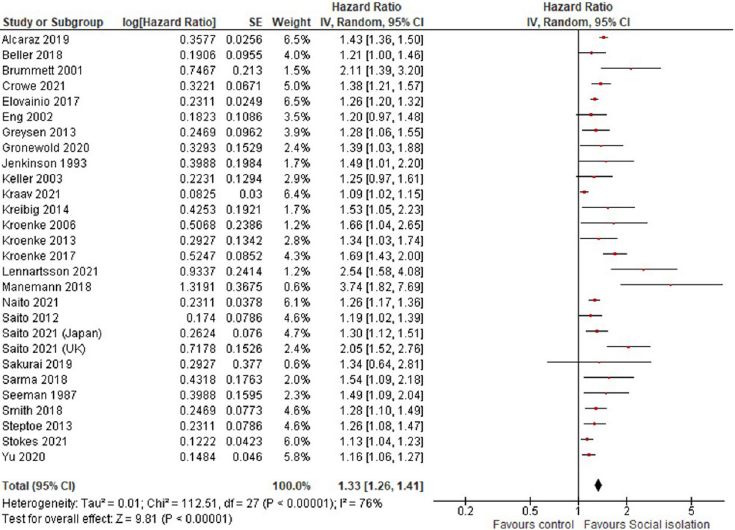
Fig 2. Forest plots and pooled estimates for hazard ratios of social isolation for all-cause mortality. The random effects weighted average hazard ratios of social isolation for all-cause mortality is 1.33 (95% CI); 1.26–1.41) with substantial heterogeneity (heterogeneity: Chi 2 = 112.51, P < 0.00001, I 2 =